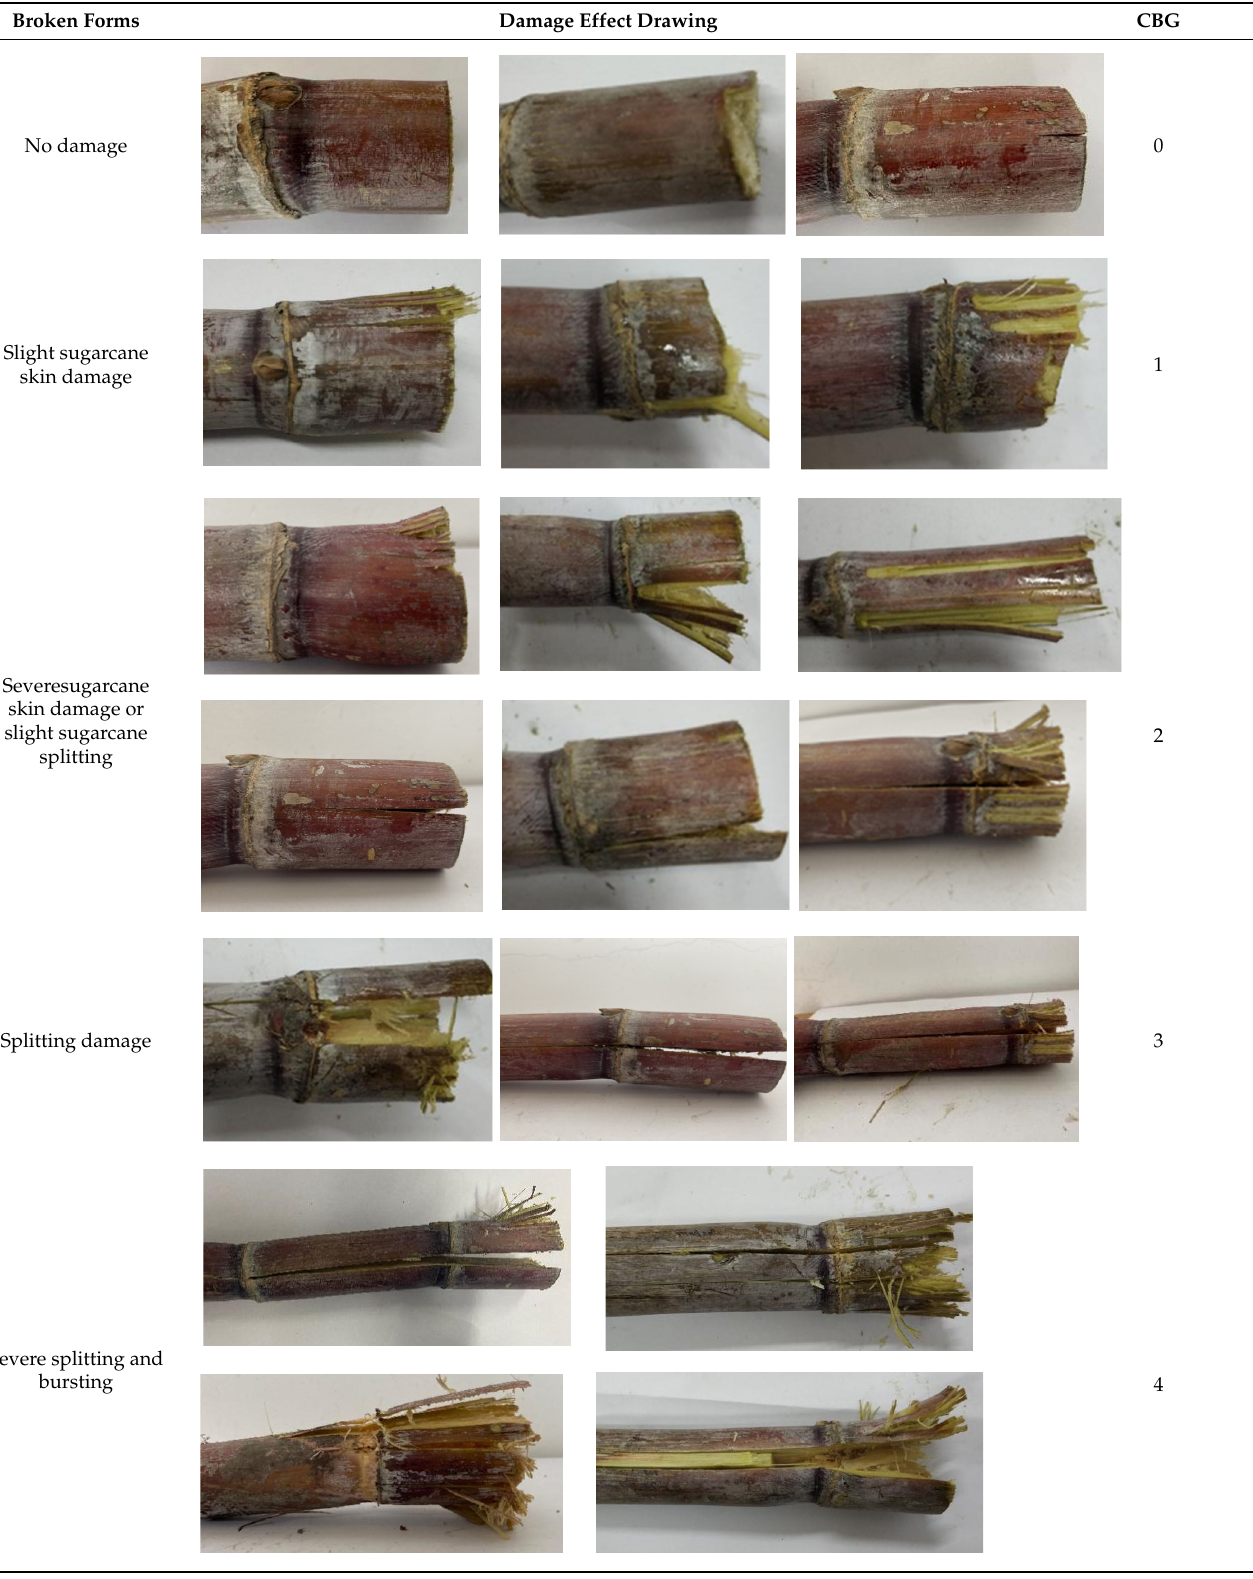
Table 3. Bench test results. Test Serial Number